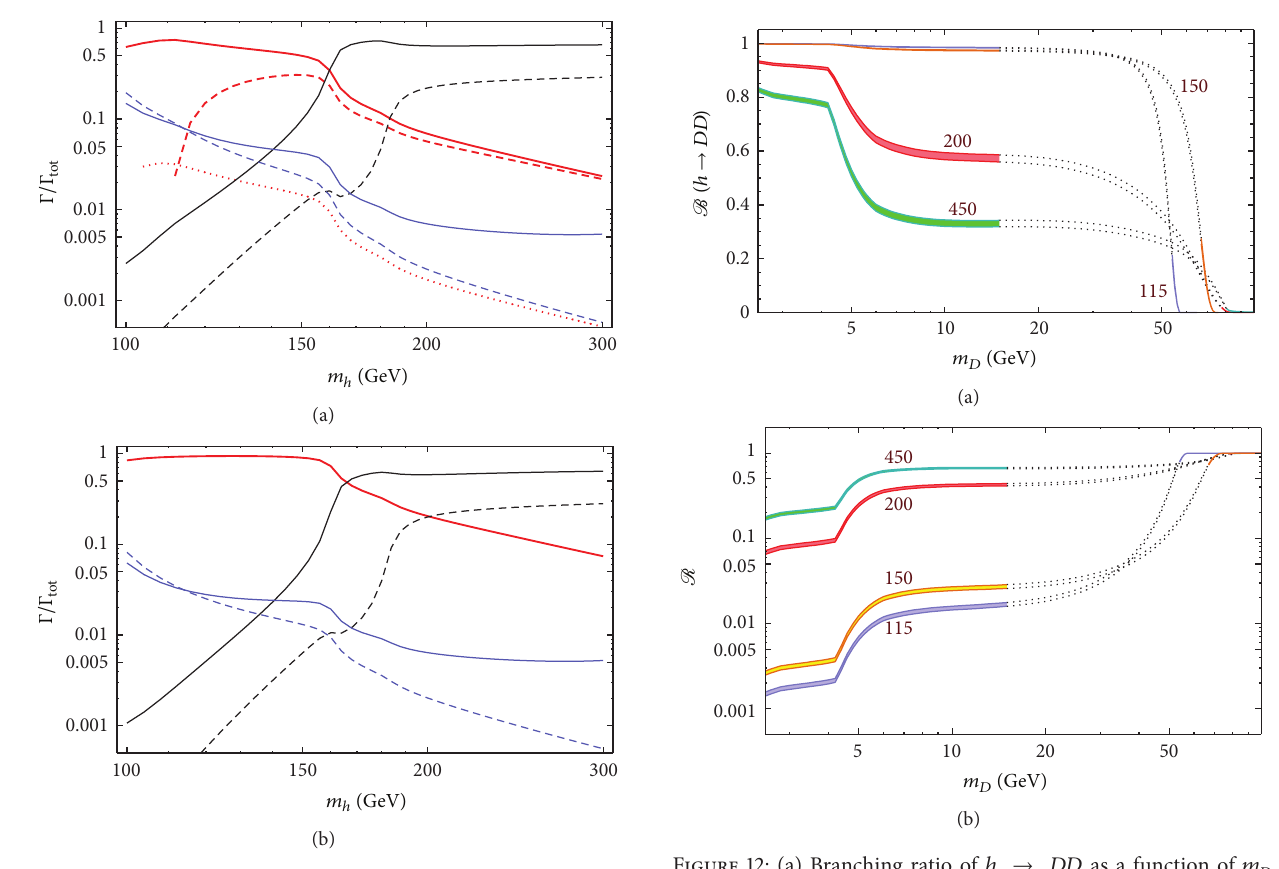
Figure 11: Branching ratios of the Higgs as a function of its mass in SM4withstablefourth-generationneutrino 𝜒 1 ofmass 𝑚 1 = 45 GeV anditsheavierpartner 𝜒 2 ofmass(a) 𝑚 2 = 55 GeVand(b) 𝑚 2 ≫ 𝑚 1 . Red thick lines represent decays into 𝜒 1 𝜒 1 (red solid), 𝜒 2 𝜒 2 (dashed), and 𝜒 1 𝜒 2 (dotted). Black lines represent decays into 𝑊𝑊 (solid) and 𝑍𝑍 (dashed). Blue lines represent decays into 𝑔𝑔 (solid) and 𝑏𝑏 (dashed). Other decays have smaller branching ratios and are not shown. Plots from [8].